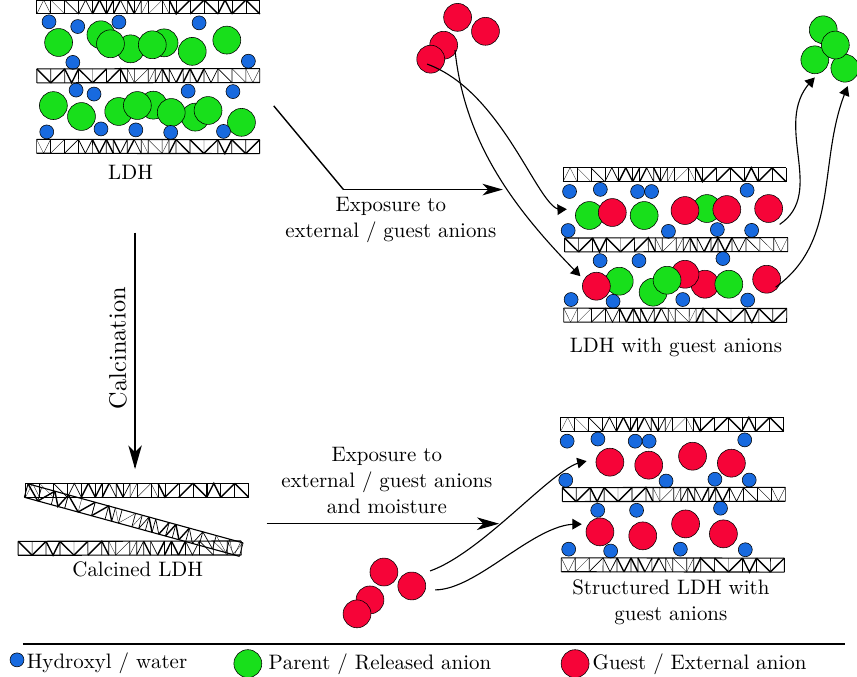
Figure 6. Schematic representation of the LDH structure and ion exchange/capture